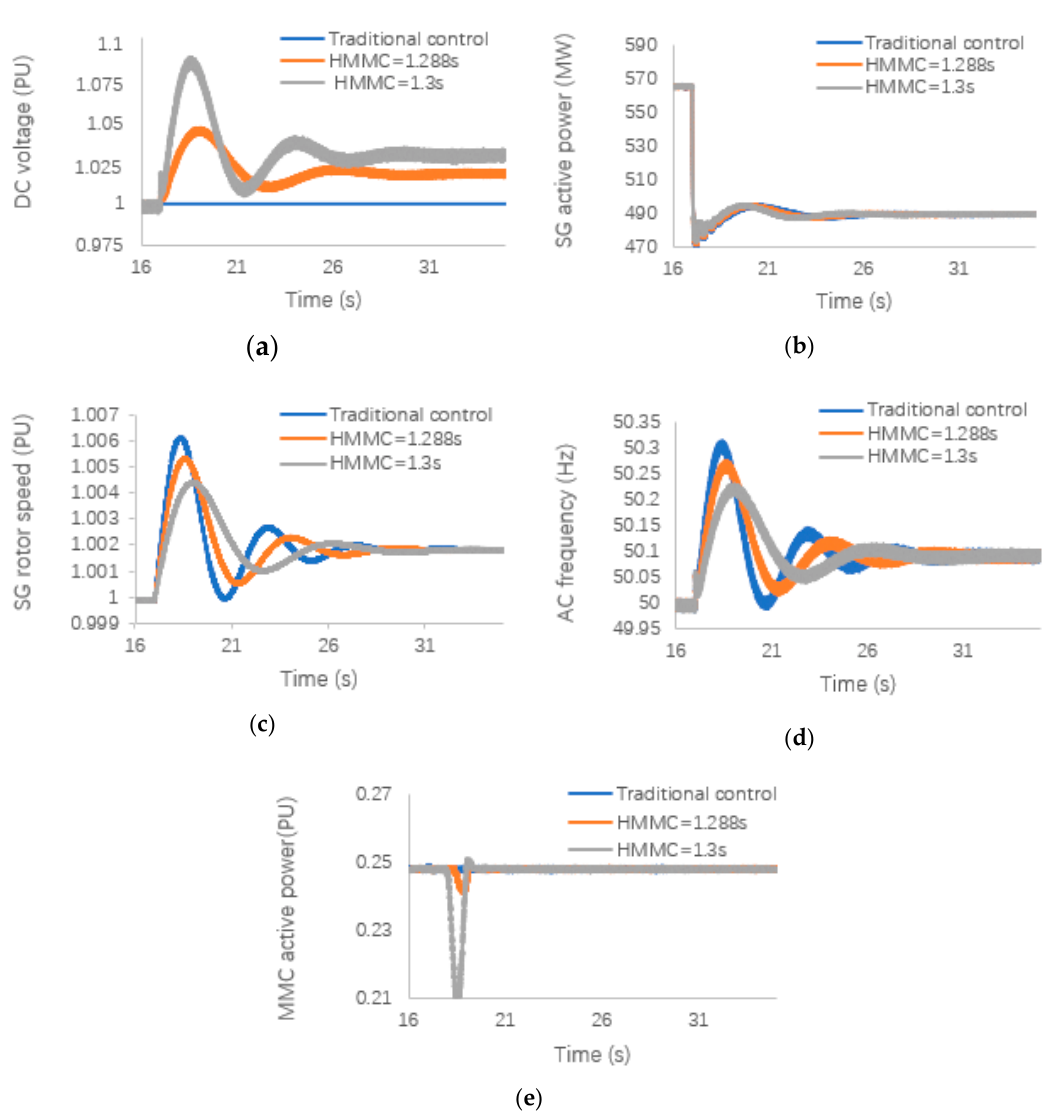
Figure 7. ESCR is 3.5 for 10% load decrease: ( a ) DC voltage; ( b ) SG active power; ( c ) SG rotor speed; ( d ) AC system frequency; ( e ) MMC active power.